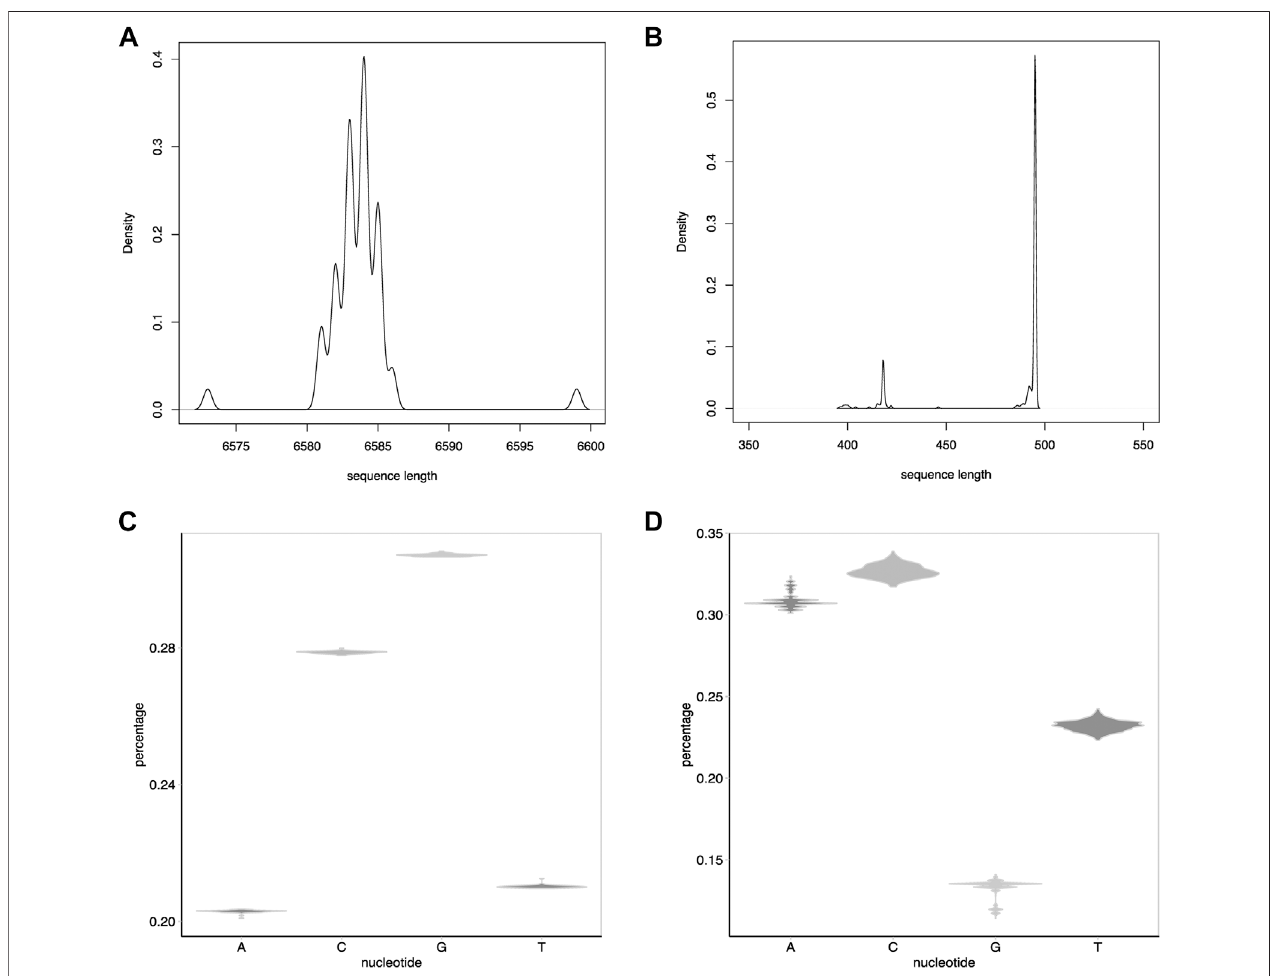
FIGURE3| Statisticsofthetwodatasetsusedinthispaper. (A) and (B) :ThedensitydistributionofthesequencelengthsforDatasetI (A) andDatasetII (B) . (C,D) :Distributionsof the percentages of each nucleotide (i.e., A, C, G, and T) for Dataset I (C) and Dataset II (D) . The numbers of sequences for Dataset I and Dataset II are 56 and 372, respectively.